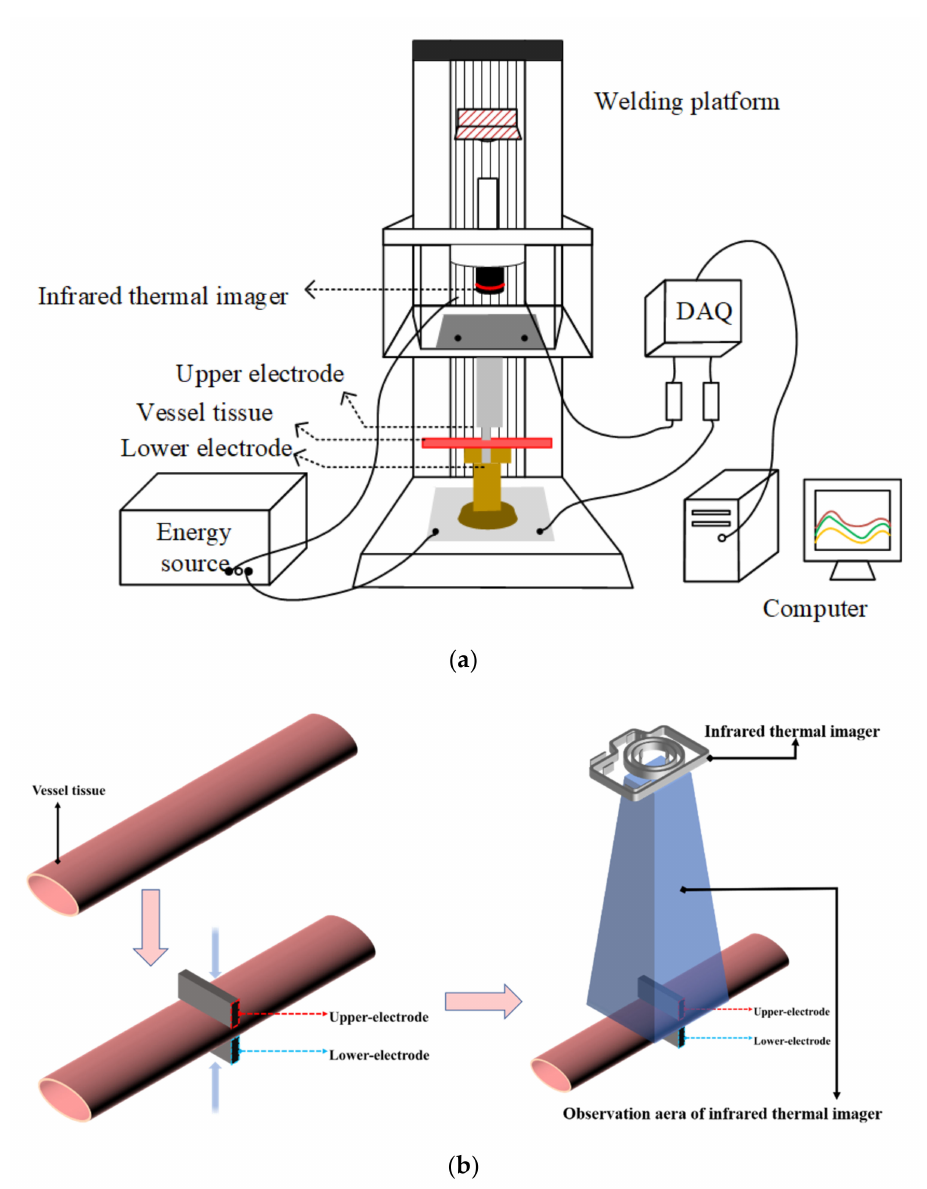
Figure 2. The treated vessel tissue is placed between the upper and lower electrodes, and sufficient pressure is applied to fix it. After the pressure is stabilized, the upper and lower electrodes deliver energy to the vessel tissue, and the infrared thermal imager begins to record the tissue temperature until the end of the welding experiment. ( a ): Schematic diagram of H.F.E.W. experimental setup. ( b ): Flow chart of vessel tissue welding